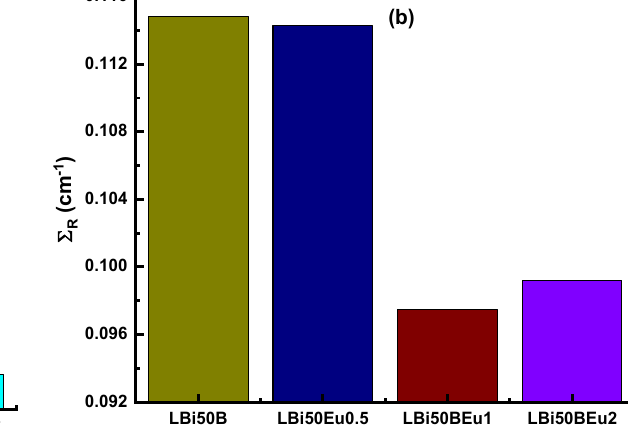
Figure 9. Effective removal cross-sections for fast neutrons ( Σ R ) for ( a ) LPb50BEu and ( b ) LBi50BEu glasses.